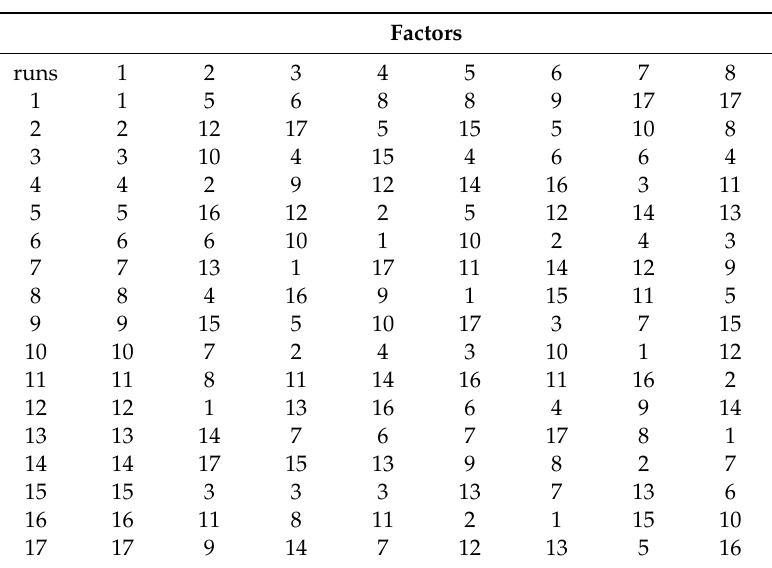
Table 5. UED table of U 17 (17 8